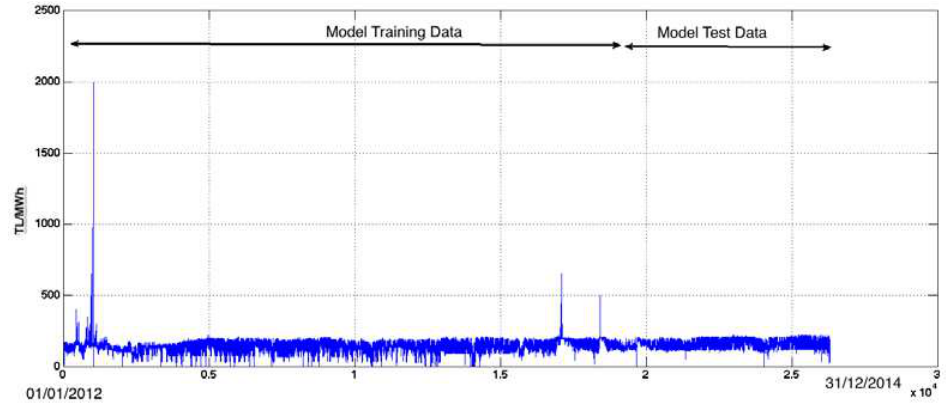
Fig. 7. Model training and test data